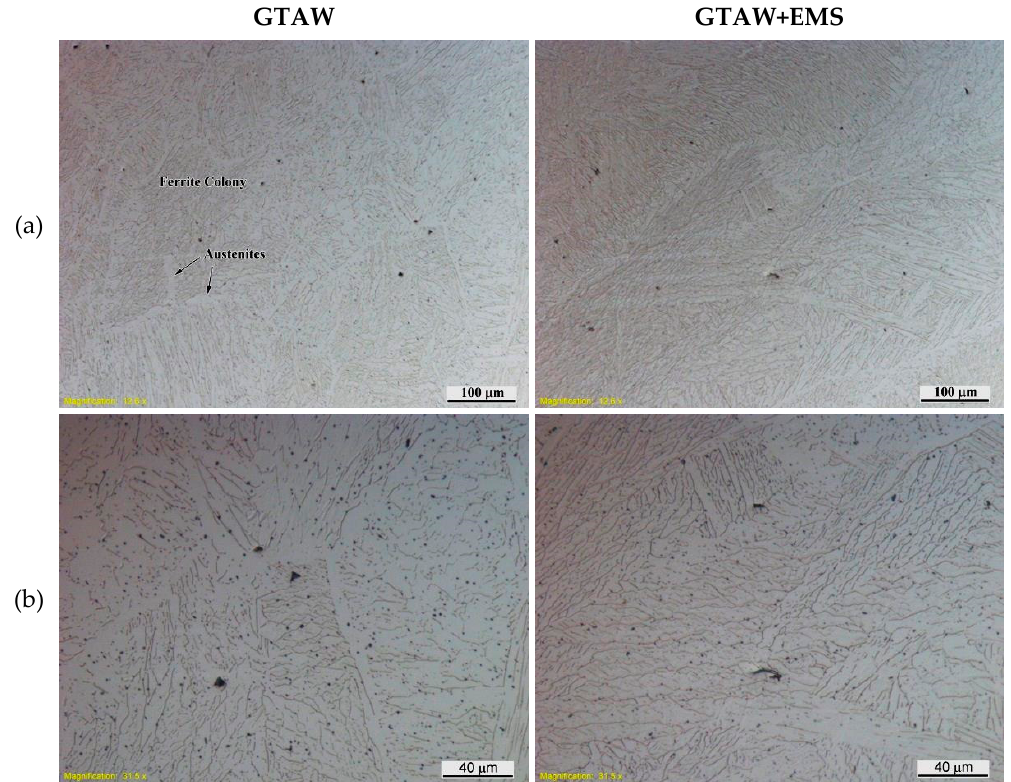
Figure 8. The OM micrographs of the middle welds at: ( a ) low magnification, and ( b ) high magnification.